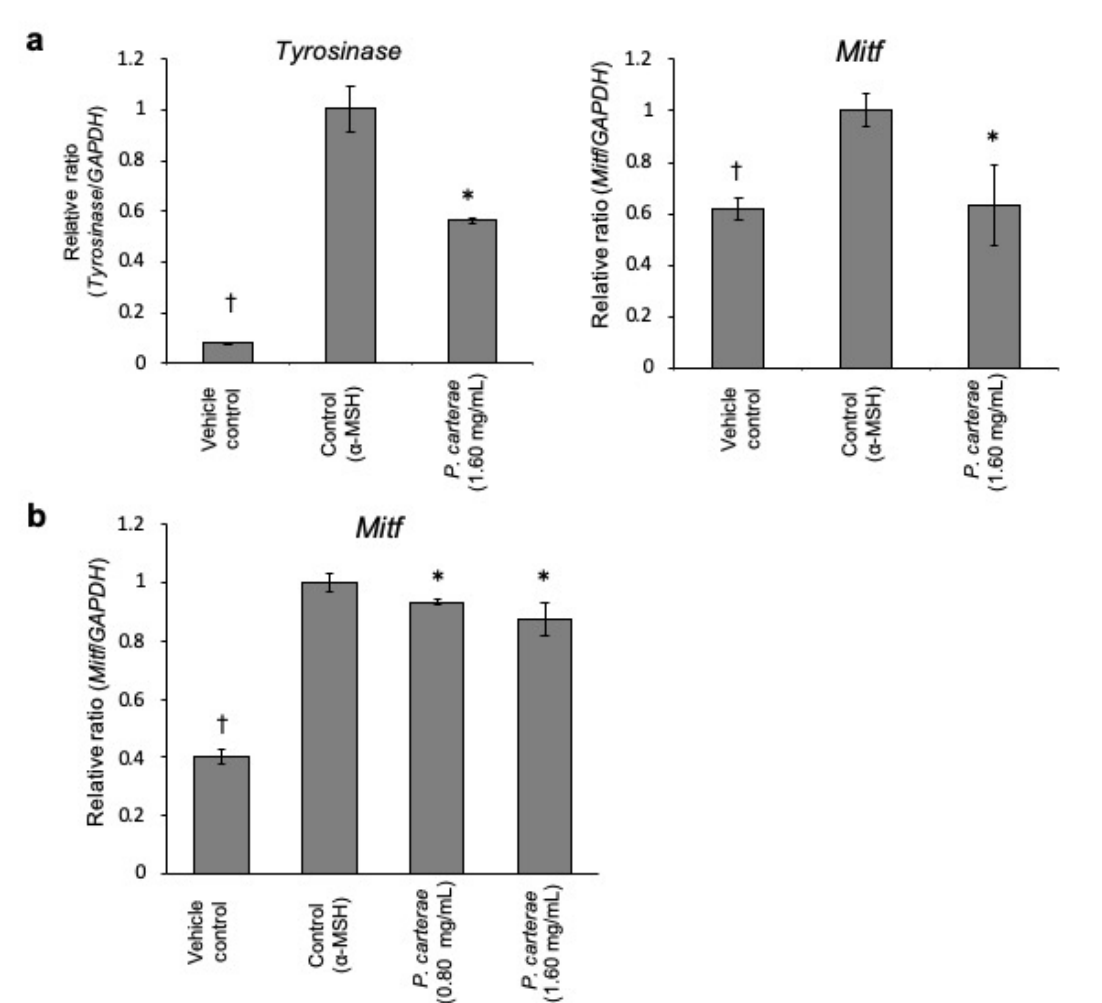
Figure 7. Melanogenic gene mRNA levels in P. carterae -treated B16F1 melanoma cells. ( a ) qRT-PCR was performed to determine the tyrosinase and MITF mRNA level in B16F1 melanoma cells after treatment with P. carterae in the presence of 10 nM α -MSH for 48 h. ( b ) Cells were treated with P. carterae and stimulated with 10 nM α -MSH for 6 h. After treatment, qRT-PCR was carried out to detect MITF mRNA level. *p < 0.01 versus α -MSH-only-treated.